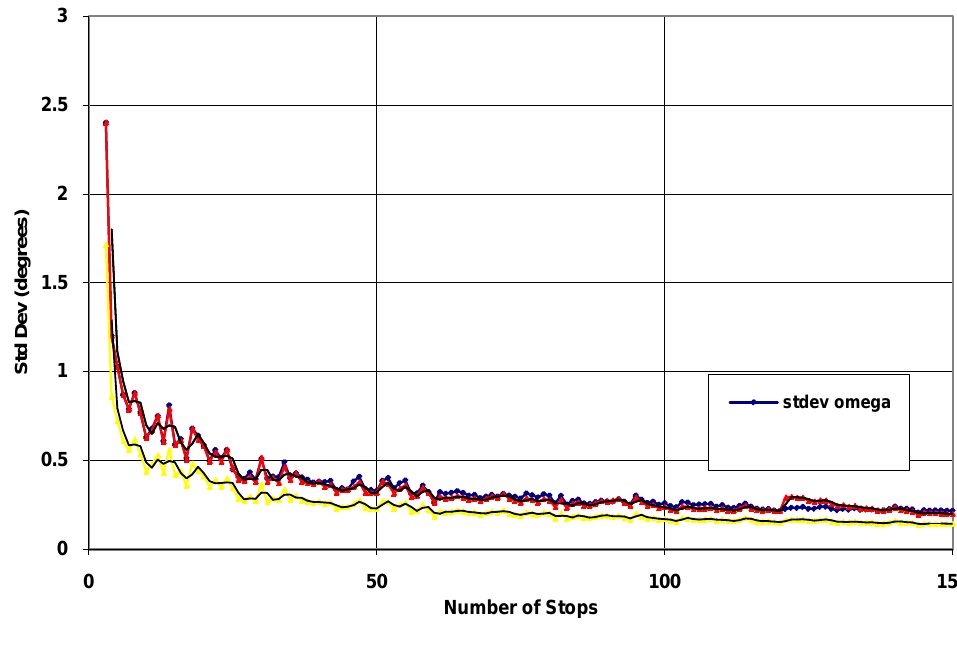
Figure 3. Simulation Results of the Single-Antenna Case showing precision of calculated orientation angles vs. number of device stops; the curve practically starts to dampen at about 20 stops, however the achieved accuracy is not close to what is required for stationary